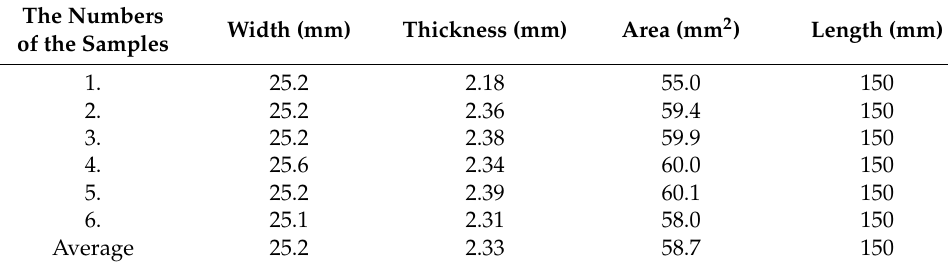
Figure 15. Appearance of samples from series B after tensile bench testing. Table 2. Geometric dimensions of Roving IMS65 reinforced composite samples.